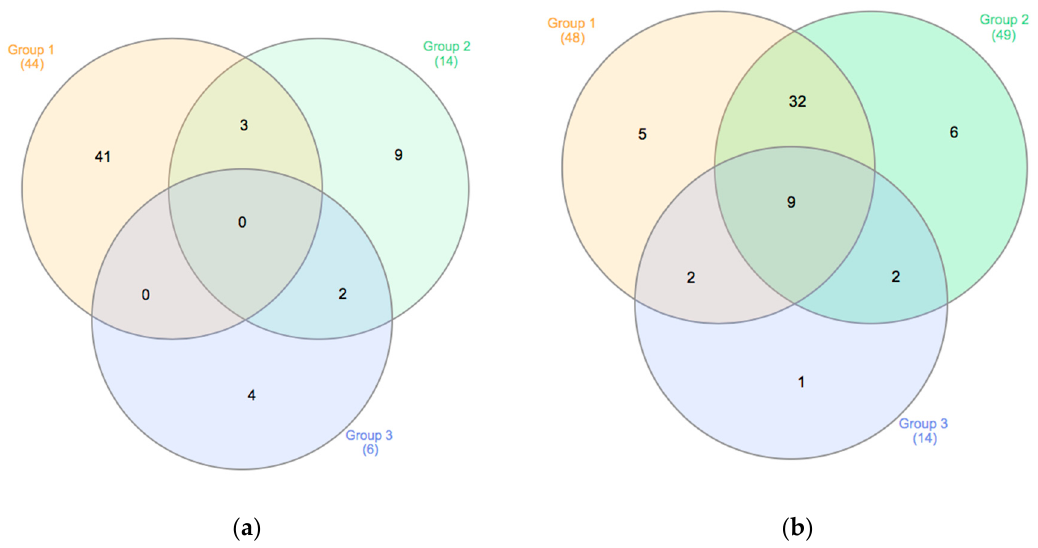
Figure 10. ‘Listening Post’ statistical data for Questions 6 in (a) and 7 in (b).